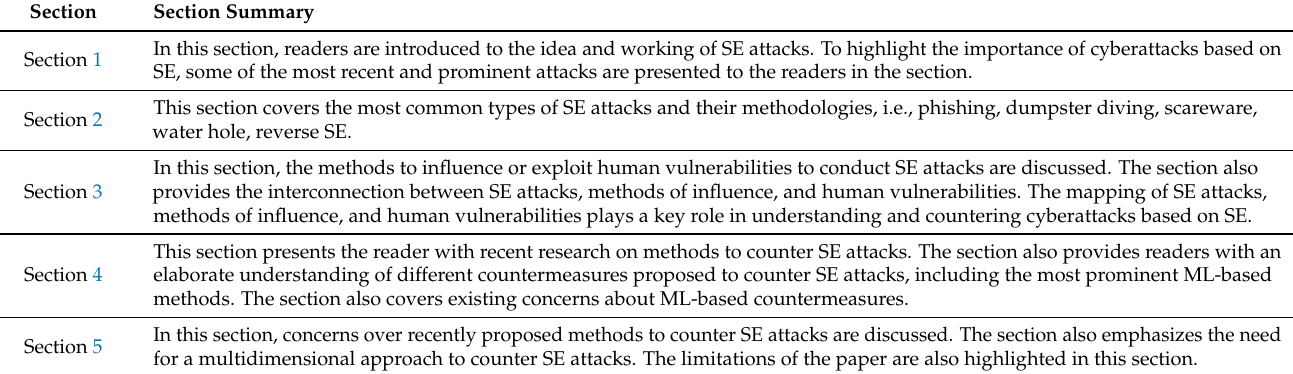
Table 10. Summary of topics covered in the